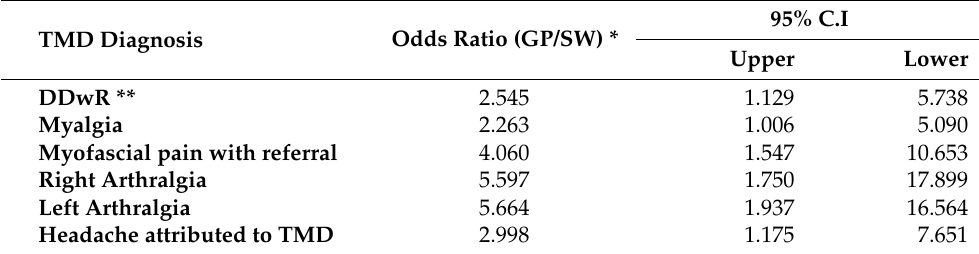
Table 4. Risk estimates of TMD diagnoses for the two